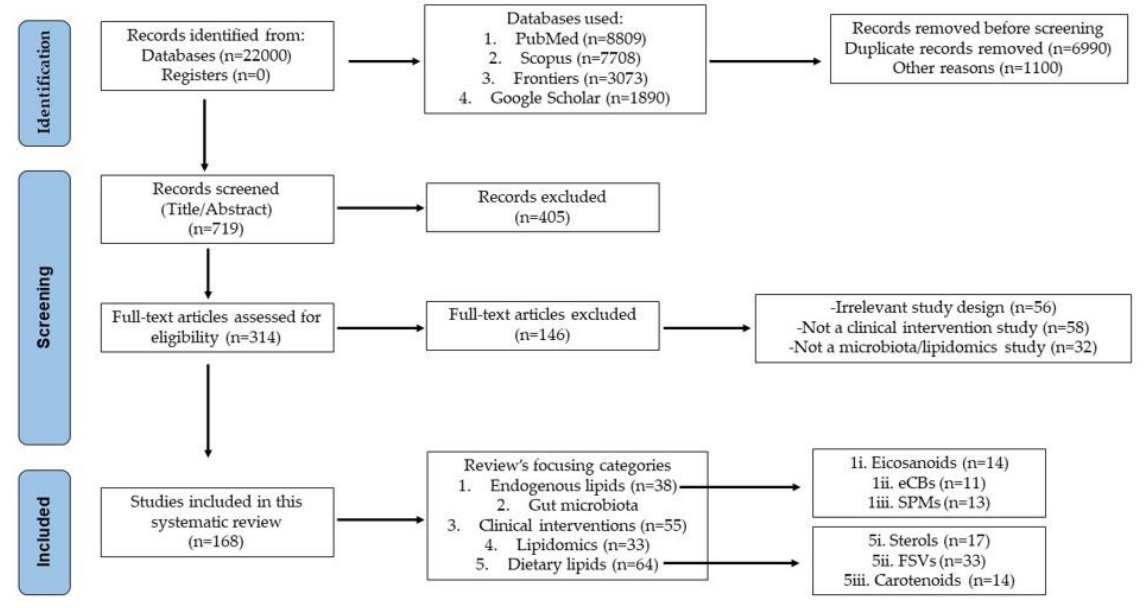
Figure 2. PRISMA flow diagram of the systematic review process.